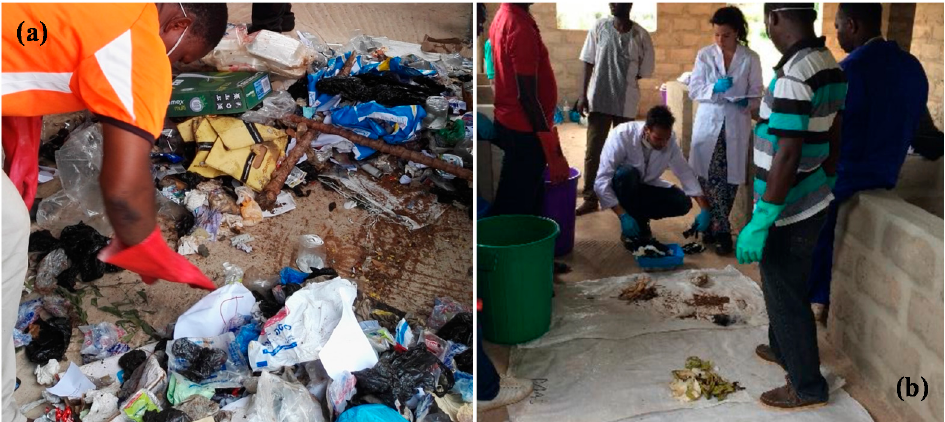
Figure 3. Laboratory work for urban solid waste characterization at the University of Lome. ( a ) Quartering and ( b ) weighing of some fractions after the separation.